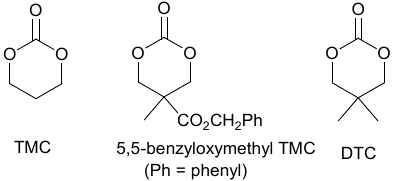
Figure 12. Structure of cyclic carbonates applicable in enzymatic ring‐opening polymerization.